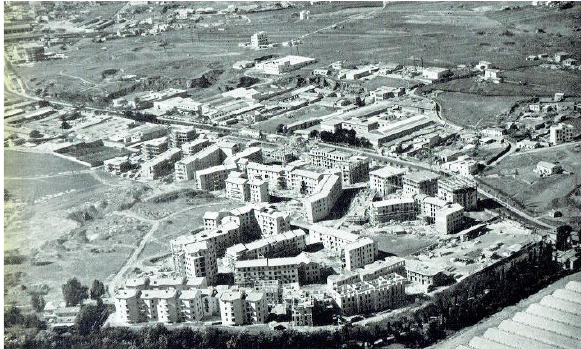
Figure 1. L. Quaroni and M. Ridolfi (group leaders), INA Casa “Tiburtino” district (1949-54) in Rome (© F. Montuori).